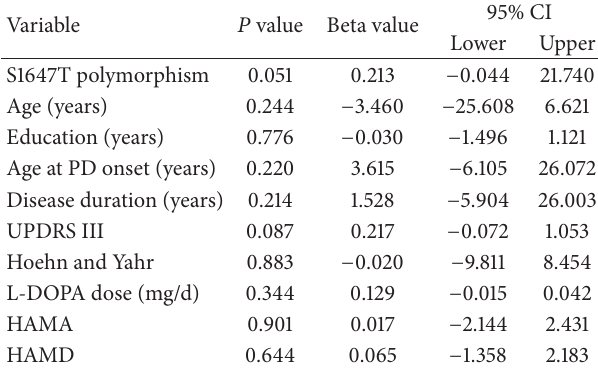
Table 3: Predictors of SWCT-TIME scores (multiple linear regres- sion